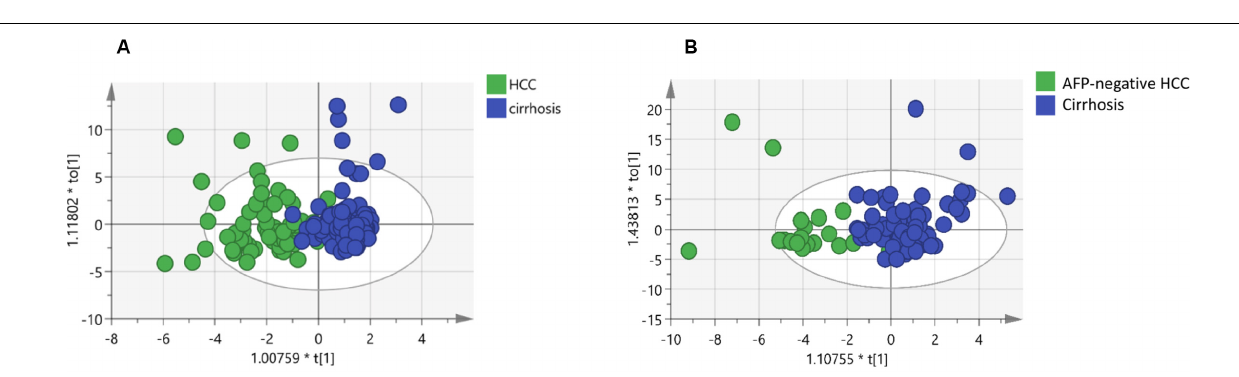
FIGURE 3 | Identification of potential biomarkers through OPLS-DA: (A) Score plots obtained from the cirrhosis ( n = 104) and HCC patients ( n = 72). (B) Score plots obtained from the cirrhosis ( n = 104) and AFP-negative HCC ( n = 24) patients. Different colors of these dots represent different groups which are well separated based on sphingolipid levels. Also, the data indicate serum sphingolipidome varies significantly among groups. The scatter plot of t[1] vs to[1] is a window in the X space in which the separation of the two classes of observations occurs in the horizontal (t1) direction. The vertical (to[1]) direction expresses within class variability. * means t[1] or to[1] multiply by a coefficient, all these were automatically generated by the SIMCA